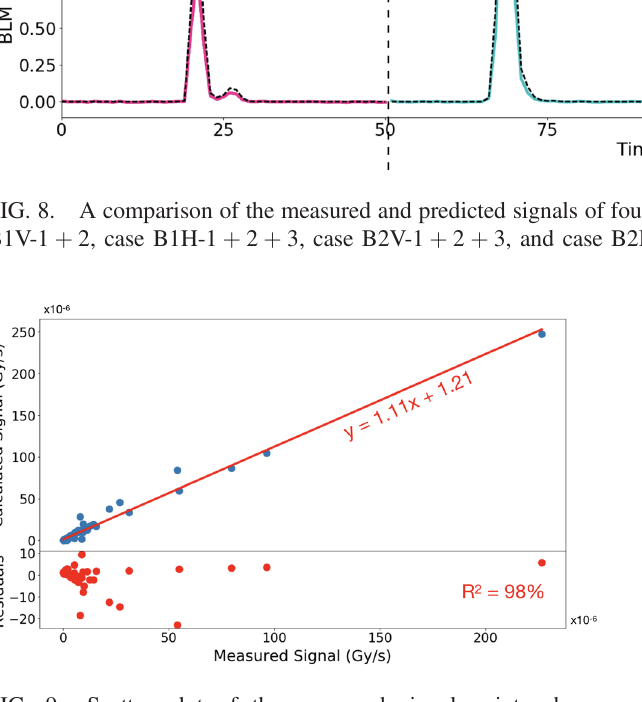
FIG. 9. Scatter plot of the measured signal points above 10 − 7 Gy = s, against the calculated signal points. A linear fit was applied to the data, and its residuals were also plotted.